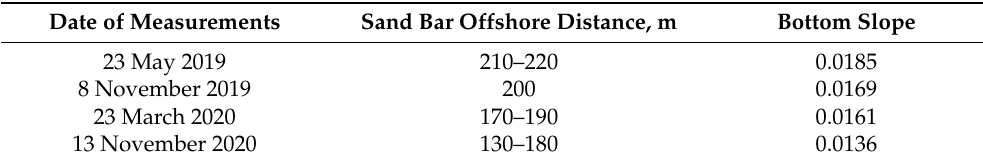
Table 1. Distance from the shoreline to the sand bar crest (location of the sand bar) and incline of the seaward bottom slope of the sand